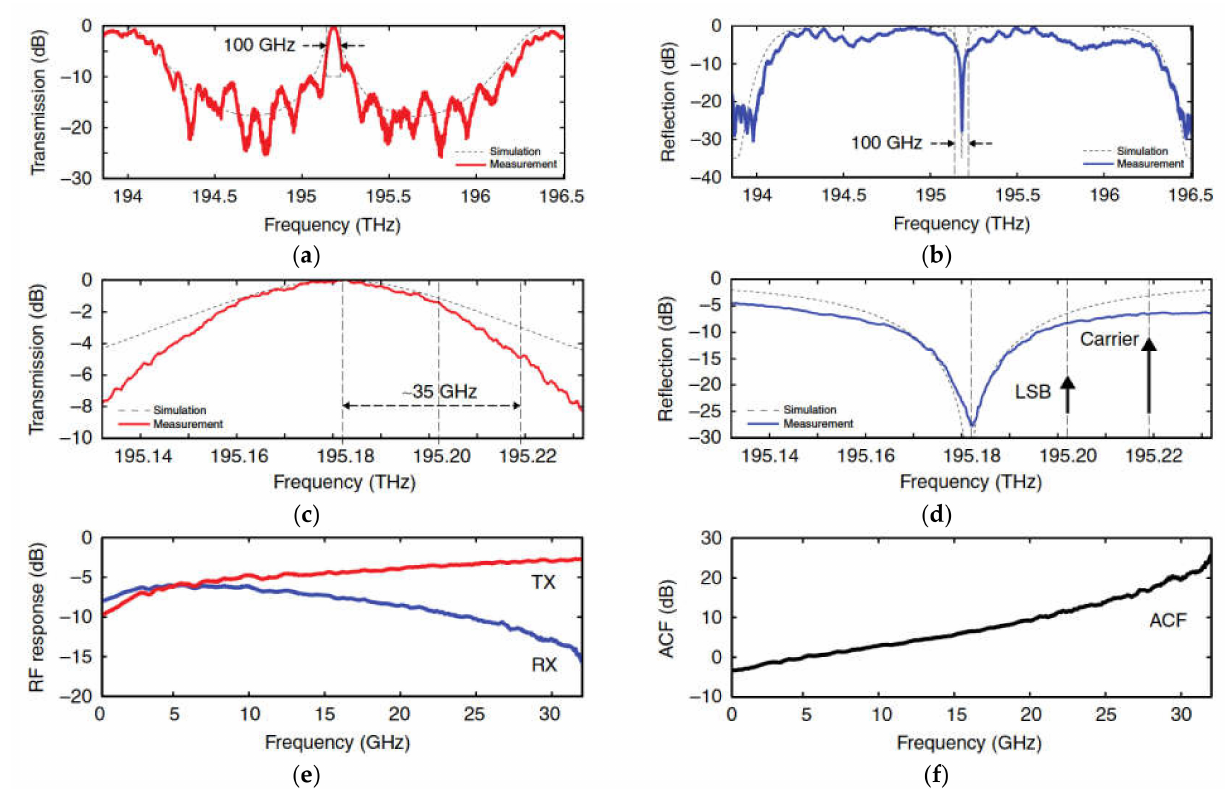
Figure 16. Optical and RF responses. Simulated (dashed line) and measured (solid line) ( a ) linear optical transmission of the PS-WBG; ( b ) reflection spectral response of the PS-WBG; ( c , d ) zoomed view of overlapped optical single sideband with carrier (OSSB + C) spectrum; ( e ) RF response of TX and RX ports; ( f ) amplitude comparison function